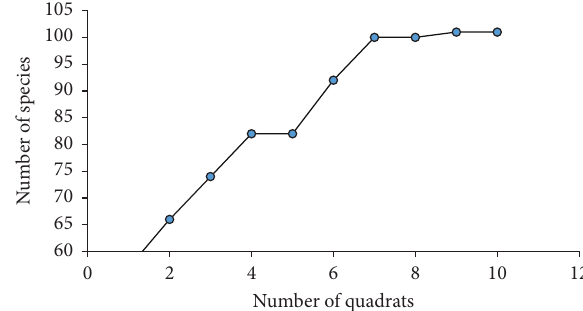
Figure 2: Species accumulation curve for sample size